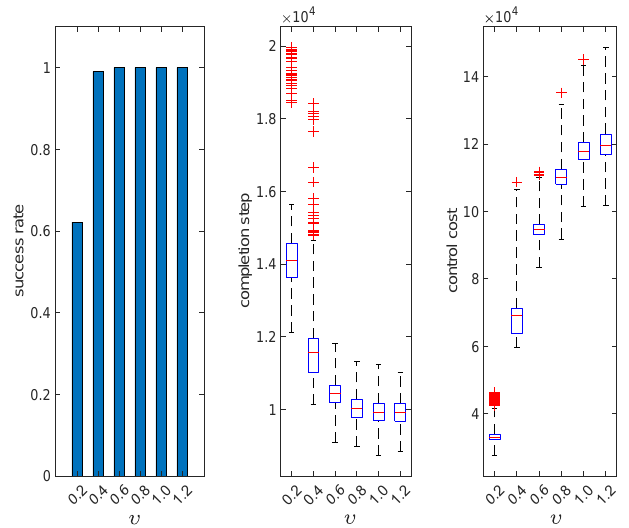
Figure 16. The algorithm performance with respect to the variations of υ .